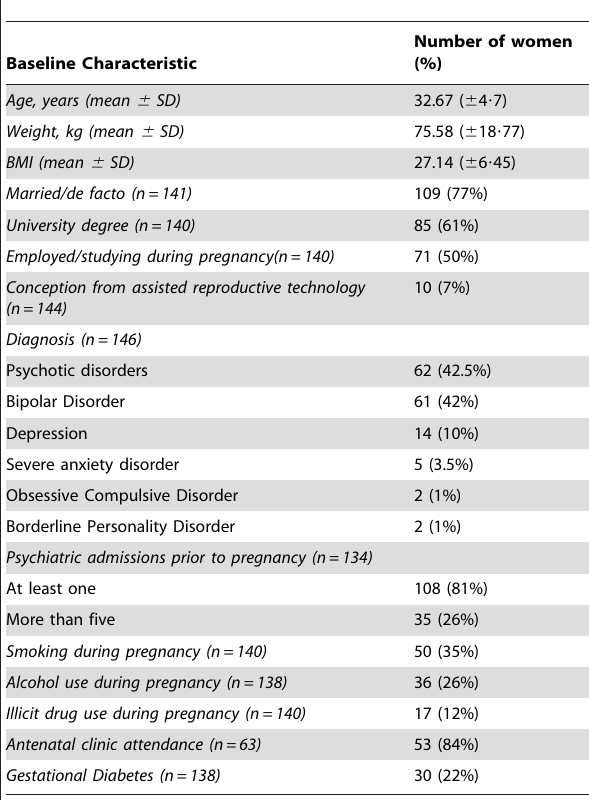
Table 1. Characteristics of mothers in